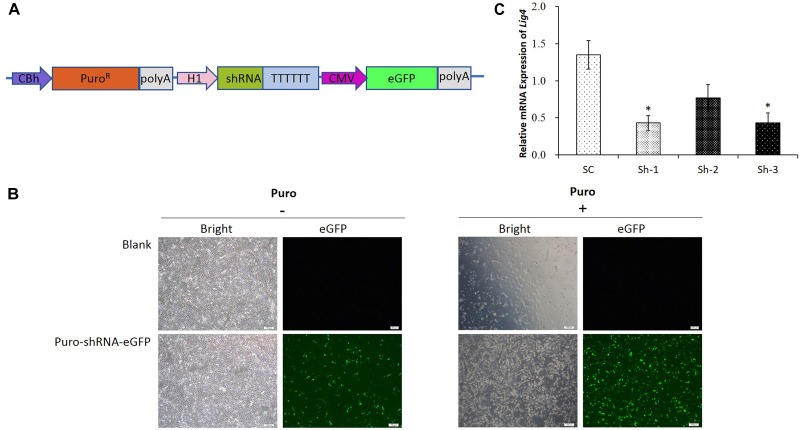
shRNA verification for porcine LIG4 gene interference. (A) The diagrammatic drawing of the PuroR-shRNA-eGFP cassette, which contained the PuroR gene for the puromycin selection of transfected cells, as well as the fluorescent eGFP gene for the visualization. (B) Representative visualization of the un-transfected and transfected PK15 cells before or after the puromycin selection. The cells transfected with the shRNA vector were enriched significantly after the selection. (C) The relative expression of LIG4 gene down-regulated by different shRNAs. The data was analyzed by Student’s t-test (n = 3, ∗P < 0.05 compared with SC). SC, the non-specific shRNA control.